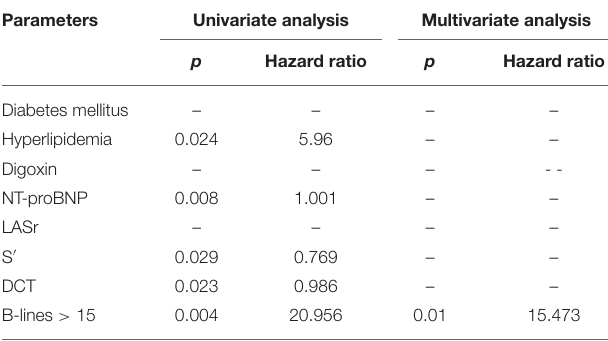
TABLE 2 | Cox regression analysis demonstrating the prognostic capacity of the predictor parameters.